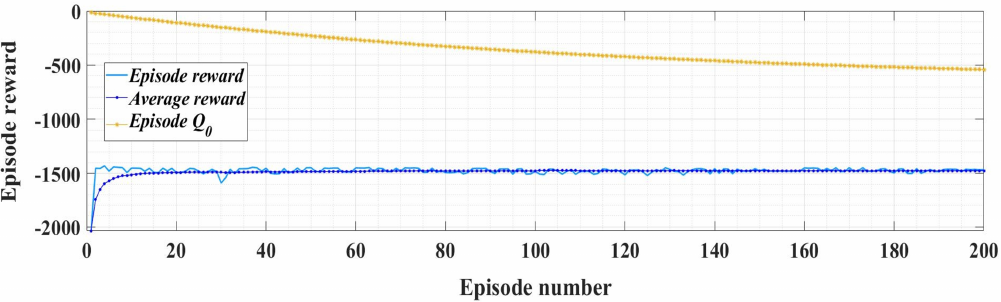
Figure 7. Performance of the RL-TD3 algorithm based on reward evolution.